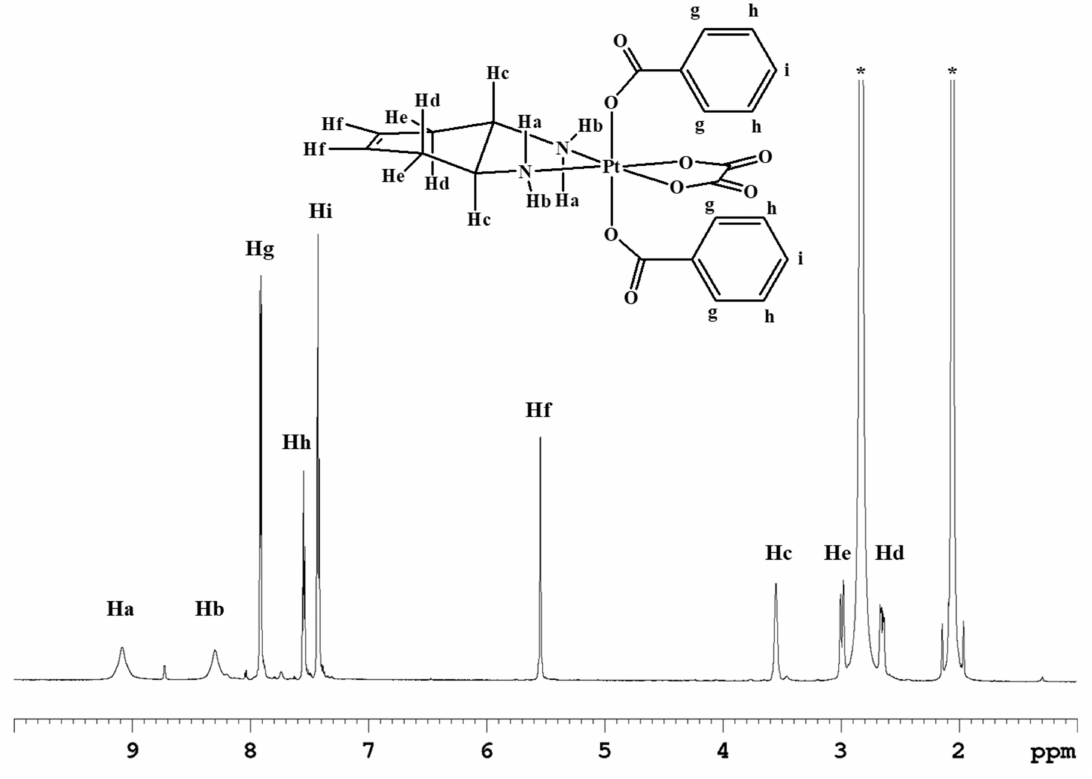
Figure 3. 1 H-NMR spectrum (700 MHz, 1 H) of 3 in acetone-d 6. * indicates residual solvent